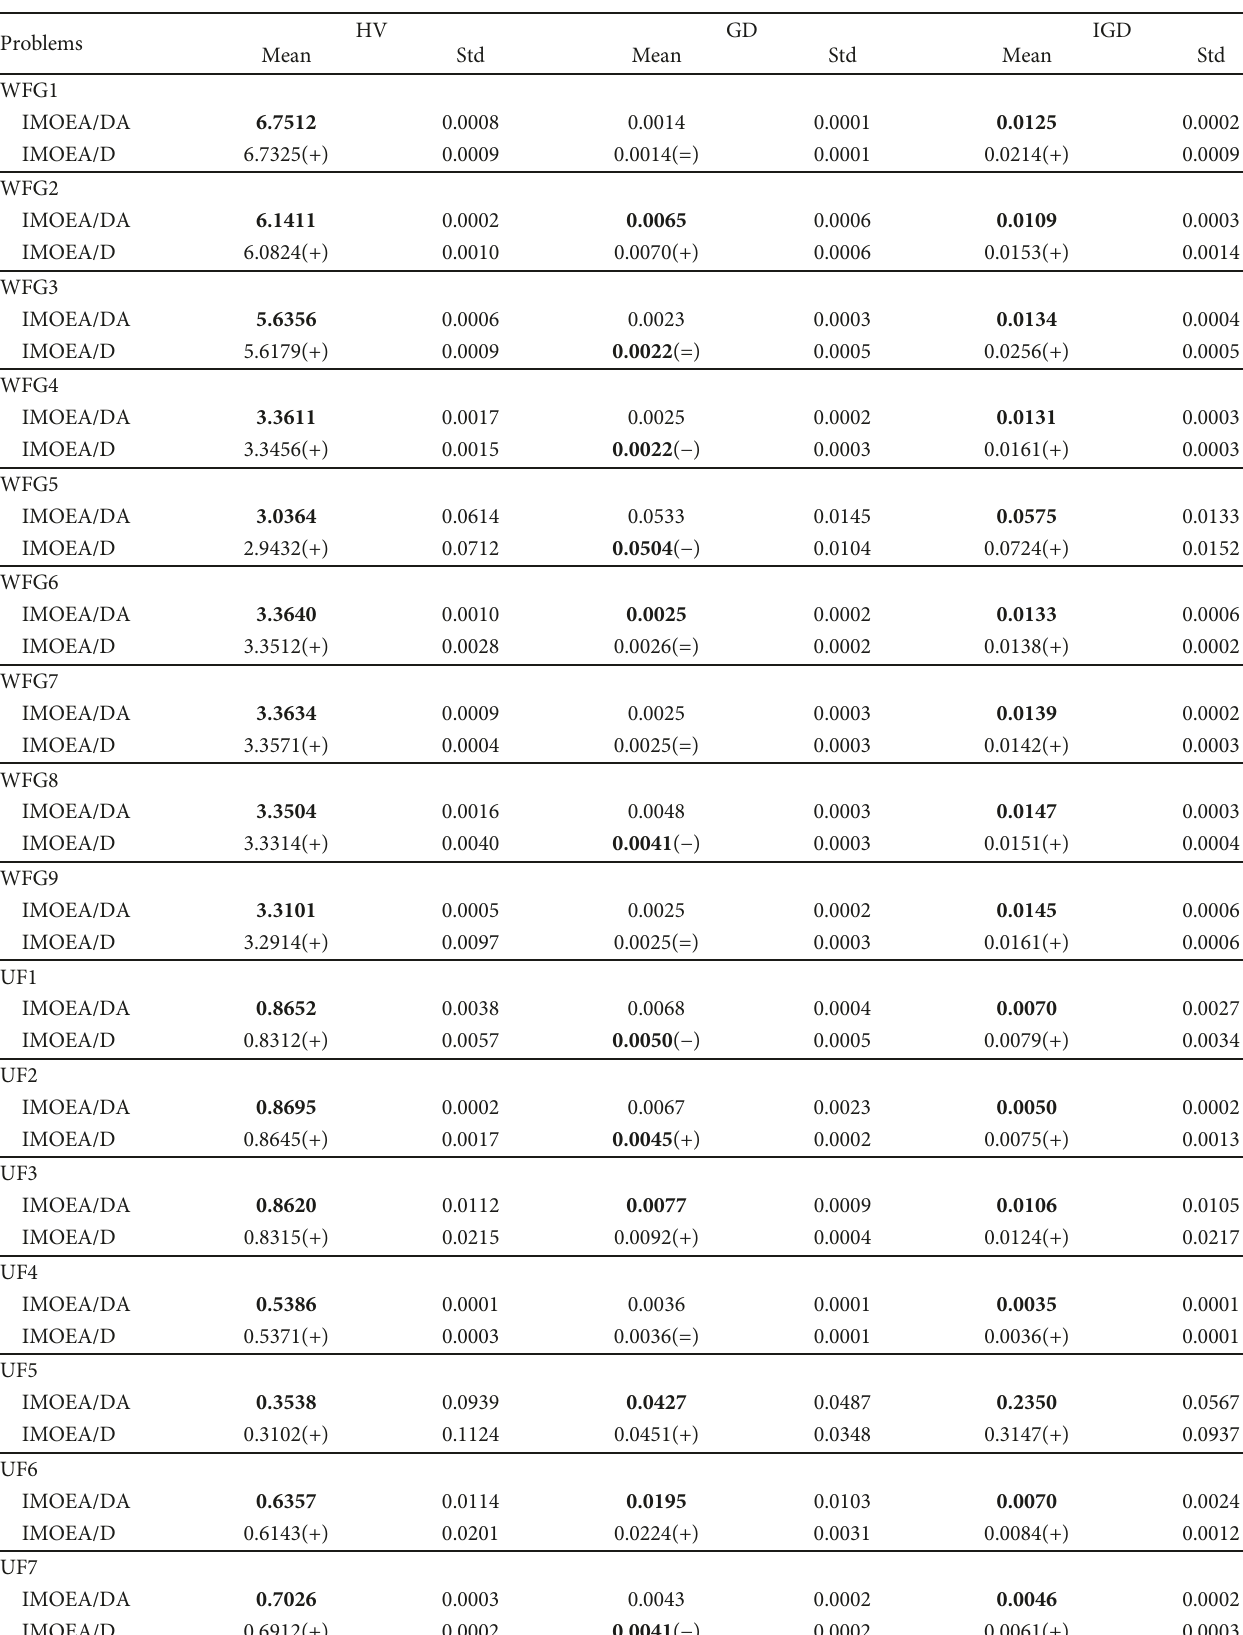
Table 6: HV, GD and IGD obtained by IMOEA/DA and